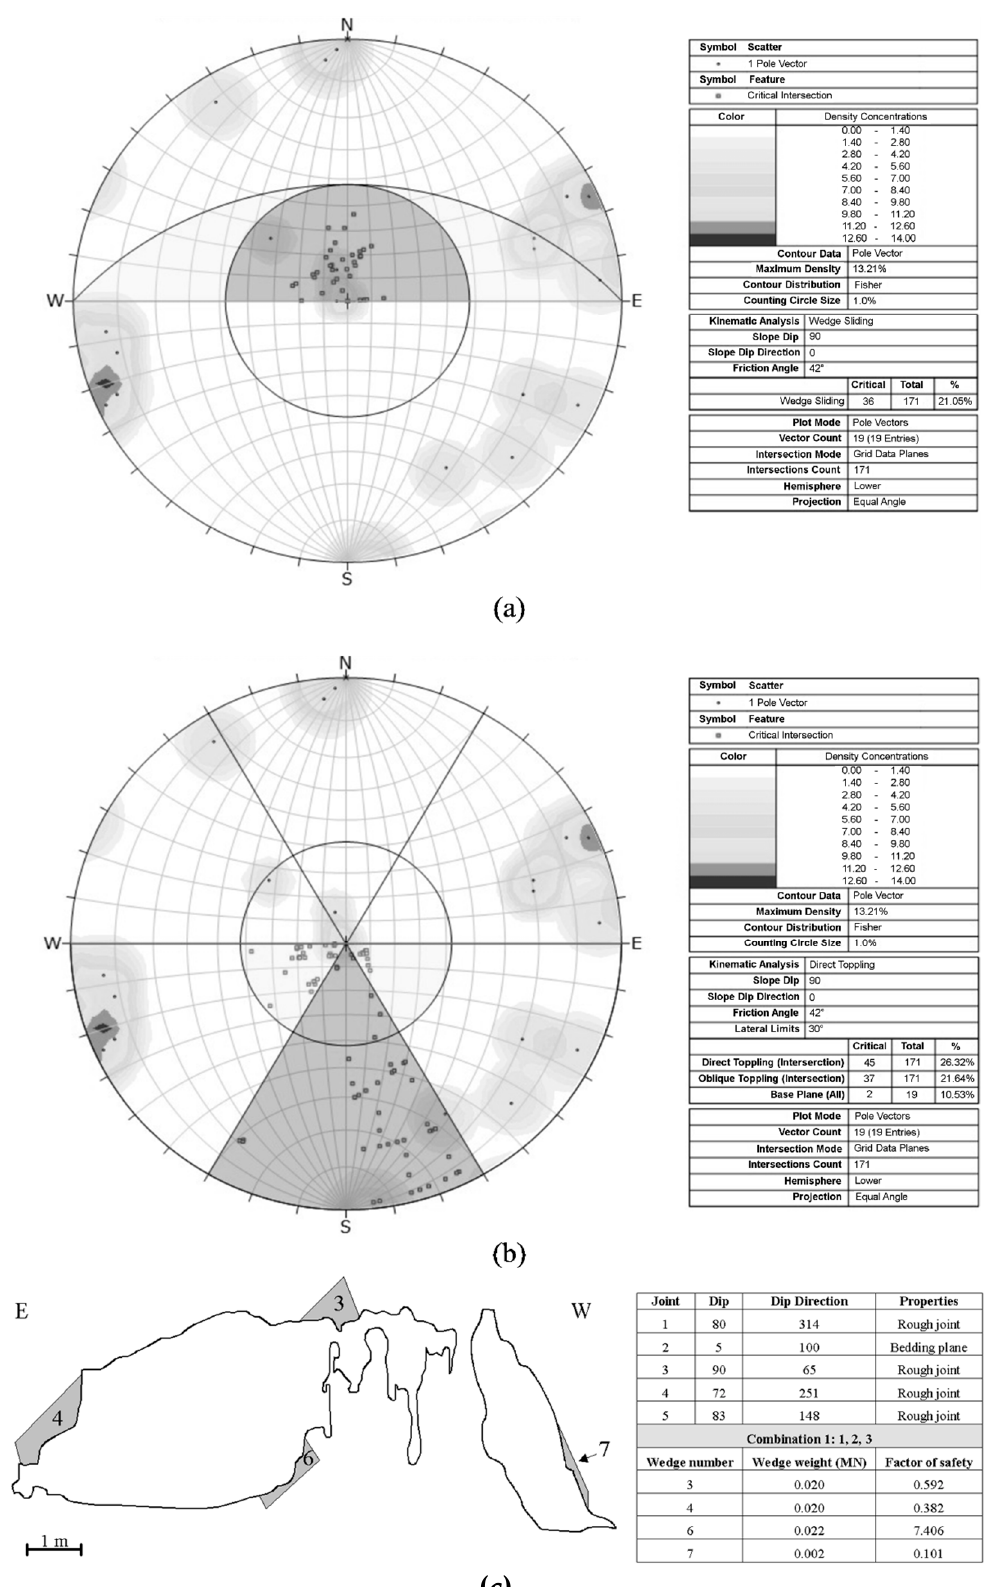
Figure 8. Examples of potential instability analysis of the rock masses of the Sant’Angelo in Criptis Cave along the section 4. ( a ) kinematic analysis of wedge and ( b ) direct toppling failures using stereographic projections; ( c ) deterministic analysis for the joint combination 1, using the Unwedge program, based on Goodman-Shi key block theory.